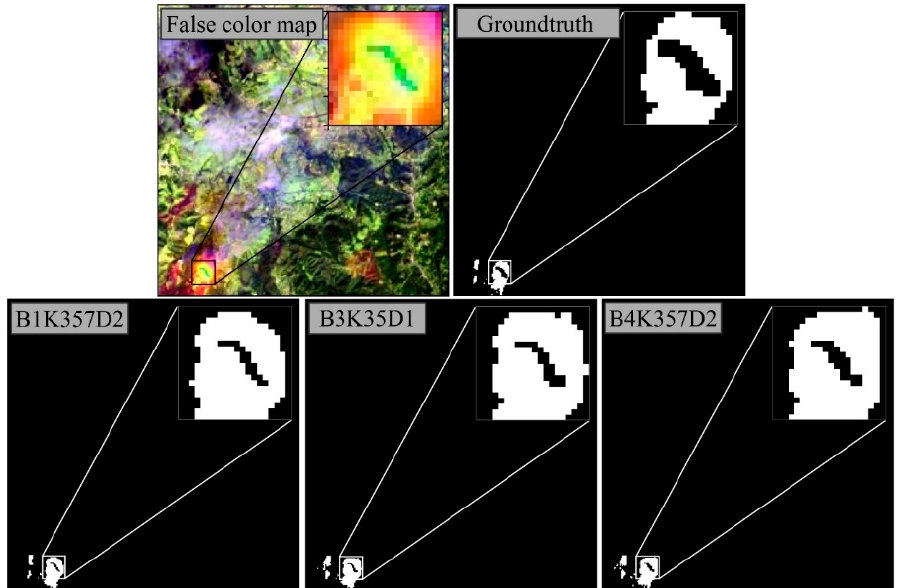
Figure 7. Pixel saturation issue in AFD in Landsat-8 images.